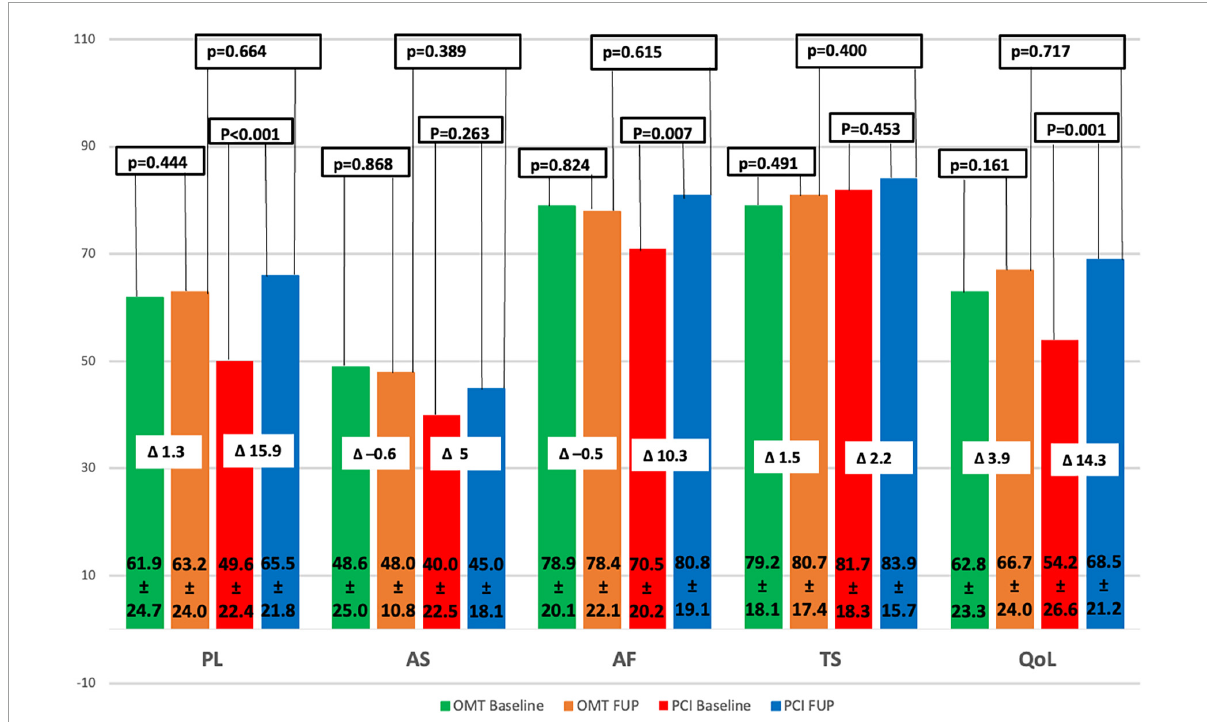
FIGURE3 SAQ subscale changes. QoL, quality of life; PL, physical limitation; AS, angina stability; AF, angina frequency; TS, treatment satisfaction; PCI, percutaneous coronary intervention; OMT, optimal medical therapy; FUP, follow-up. (cid:49) : difference between f-up and baseline mean